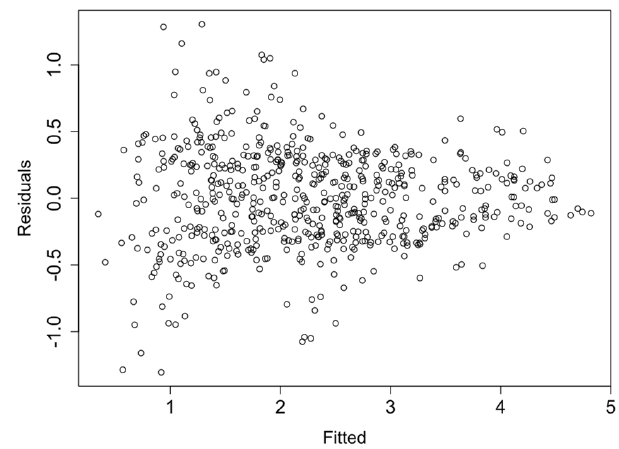
Figure 14. Fitted vs. residual values—Group 2.